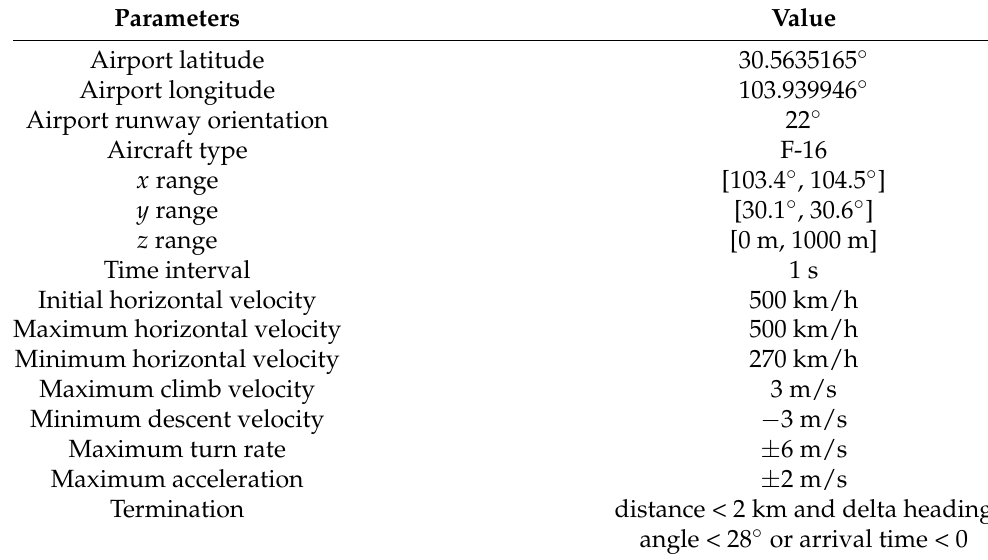
Table 2. Simulation environment settings.